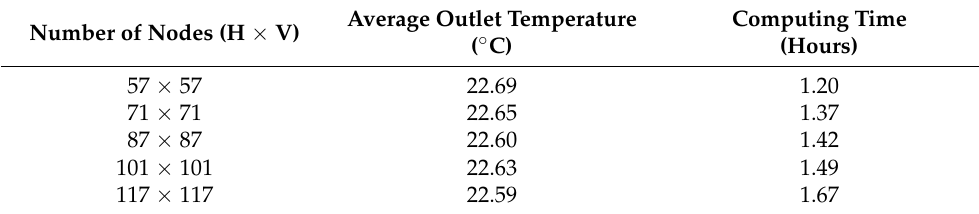
Table 4. Average outlet temperature and computing time for each